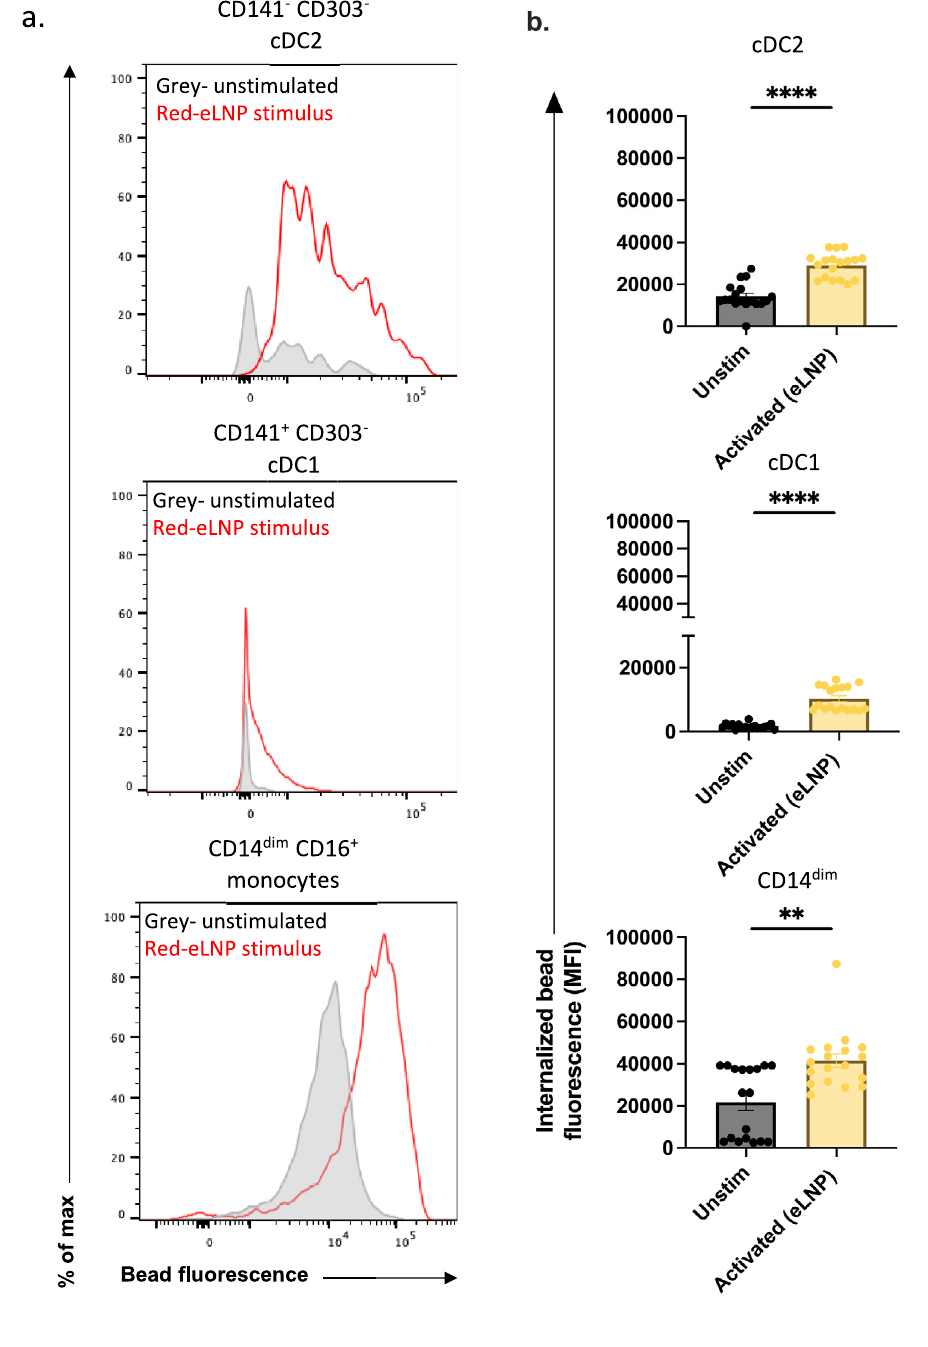
Fig. 3 Phagocytosis is induced in cDC2, cDC1, CD14 dim CD16 + monocytes in response to eLNP stimulation. Phagocytosis measured using fl uorescent beads and multiparametric fl ow cytometry. PBMCs were incubated overnight with stimulus (15 μ g/mL (total lipids, or ~7.5 μ g/mL ionizable lipid) eLNP or plain medium) and with beads for a further 3 h. a FACS plot examples of phagocytosis assay as geometric mean fl uorescent intensity (MFI) by fl ow cytometry. b Phagocytosis after 24 h eLNP stimulation (yellow) compared to that in unstimulated cells (grey) of PBMCS. n = 18 for each group. Each individual circle represents one individual subject, n = 18. * P < 0.05, ** P < 0.01, *** P < 0.001, and **** P < 0.0001 by or non-parametric Mann Whitney